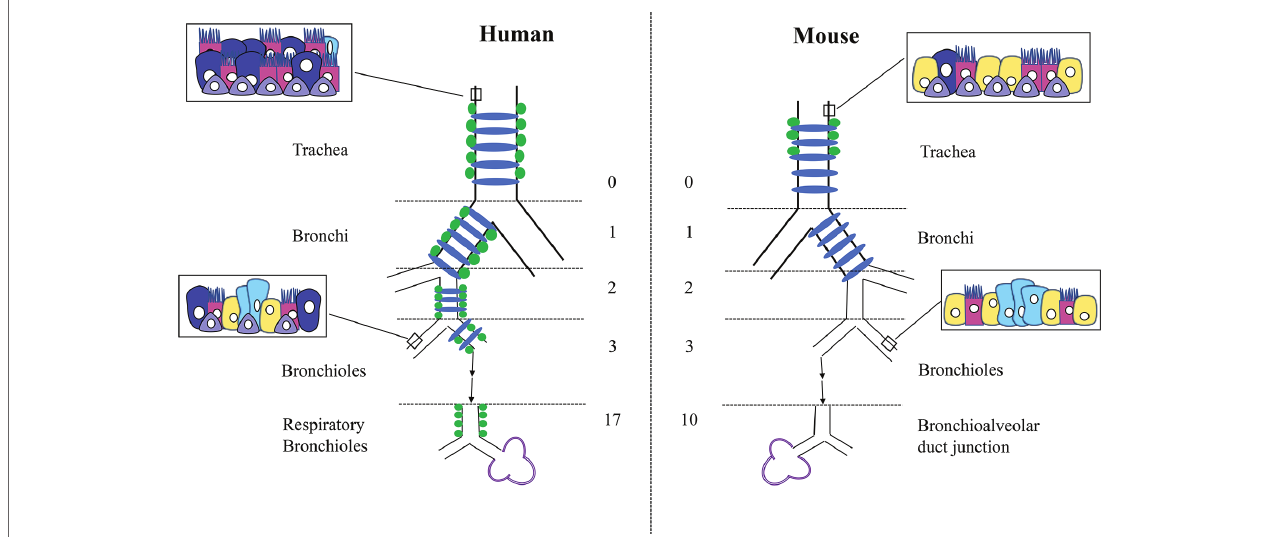
FIGURE 1 | Differences in structure and cellular composition between human and mouse lungs. Cartilage rings (blue) extend into the bronchioles in human lungs but are present only in the trachea and bronchi in mouse. Submucosal glands (green) are limited to the trachea in mouse but are present into the smaller respiratory bronchioles in humans. In mouse, only the trachea and main stem bronchi are lined with pseudostratified epithelium, whereas in humans, all the conducting airways from the trachea to the bronchioles are lined with pseudostratified epithelium. Basal cells (purple) are found deeper into the bronchioles only in humans. The human lung consists of more goblet cells (dark blue) in the proximal epithelium, with Club cells (yellow) mostly restricted to the smaller airways. Conversely, the mouse lung contains more Club cells (yellow) through the trachea and bronchi, with less goblet cells throughout. Neuroendocrine cells (light blue) are present within the bronchioles in clusters in the mouse and isolated or in much smaller clusters throughout the entire epithelial tree in human. Club cells = yellow, Ciliated cells = pink, Basal cells = purple, Goblet cells = dark blue, Neuroendocrine cells = light